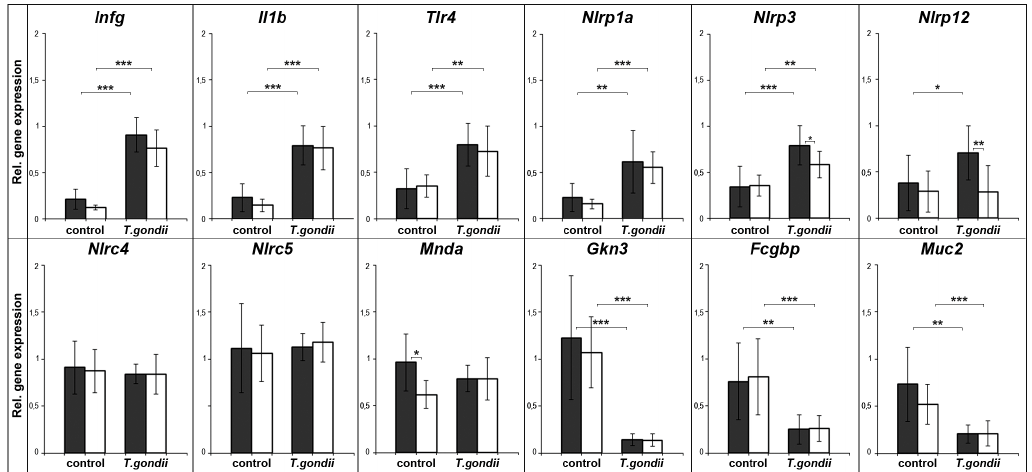
Figure 1. Semiquantitative RT-PCR analyses. Ifng (24 × ), Il1b (27 × ), Tlr4 (31 × ), Nlrp1a (33 × ), Nlrp3 (33 × ), Nlrp12 (35 × ), Nlrc4 (32 × ), Nlrc5 (32 × ), Mnda (32 × ), Gkn3 (35 × ), Fcgbp (35 × ), and Muc2 (35 × ) expression was monitored in the spleen seven days after oral T. gondii infection (ileitis model; 8 wild type and 11 Tff3 KO mice, respectively). As a control, the spleens of non-infected animals (nine wild type and nine Tff3 KO mice, respectively) were investigated. The relative gene expression levels were normalized against β -actin ( Actb , 20 × ). The number of amplification cycles is given in parentheses. Significances are indicated by asterisks (*, p ≤ 0.05; **, p ≤ 0.01; ***, p ≤ 0.001). Wild type animals: black bars; Tff3 KO animals: white bars.